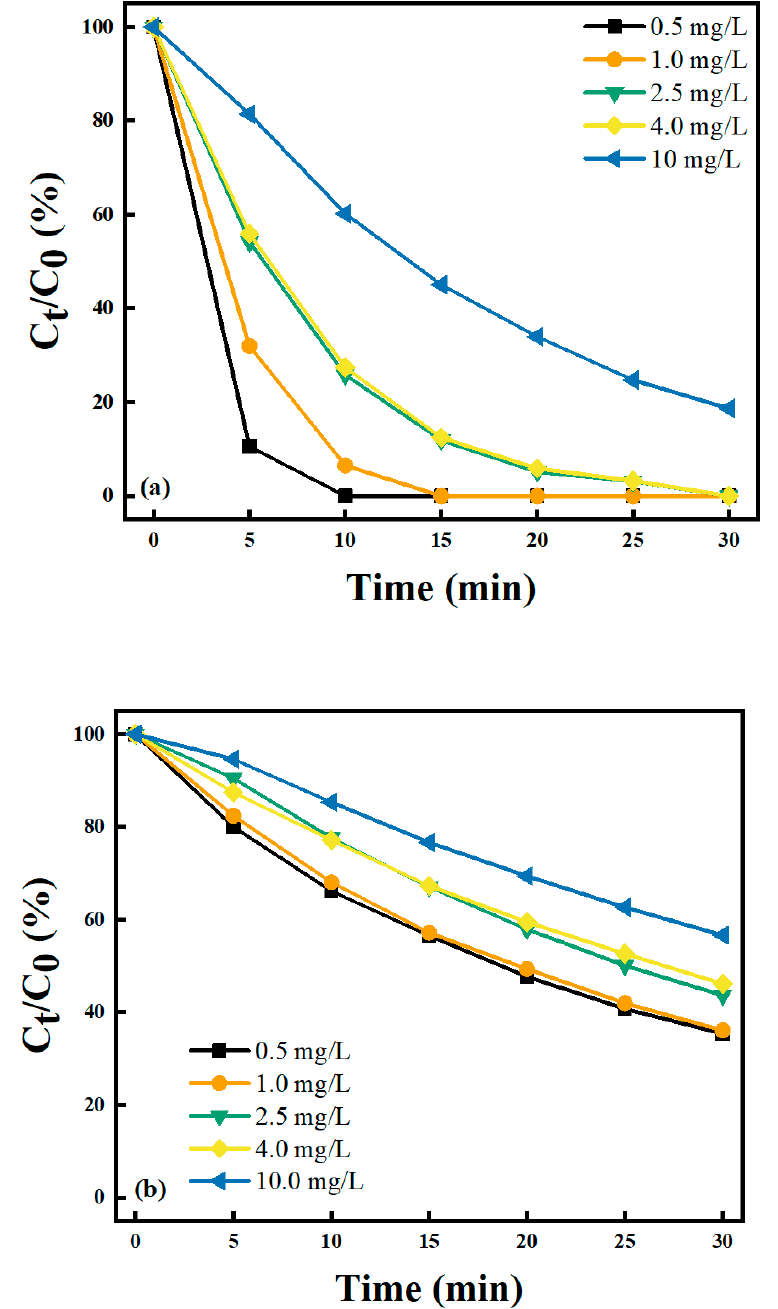
Figure 12. E ff ects of initial concentration on MNZ photodegradation under simulated sunlight Figure 12. Effects of initial concentration on MNZ photodegradation under simulated sunlight with